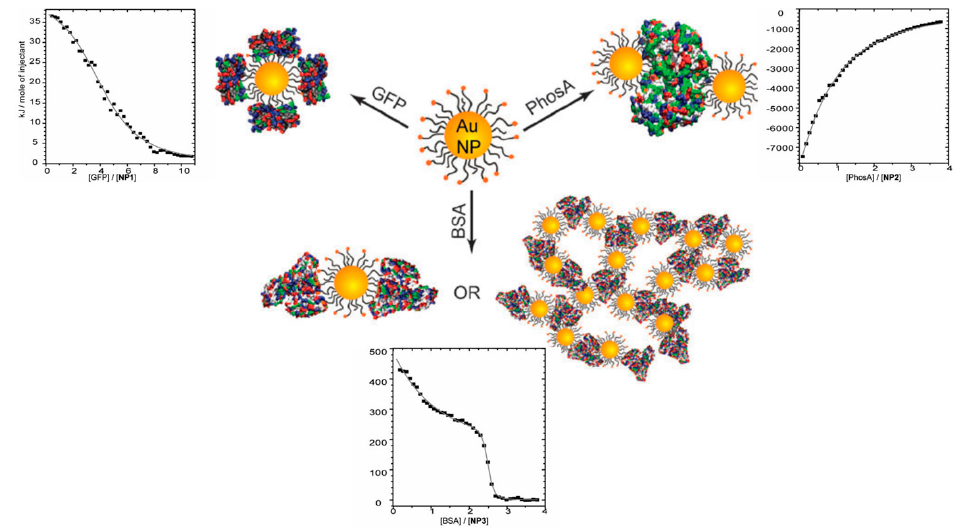
Figure 8. Binding conformations and corresponding ITC curves of charged gold nanoparticles with green fluorescence protein (GFP), acid phosphatase (PhosA), and BSA. Figure 8 was taken from the work of [48].